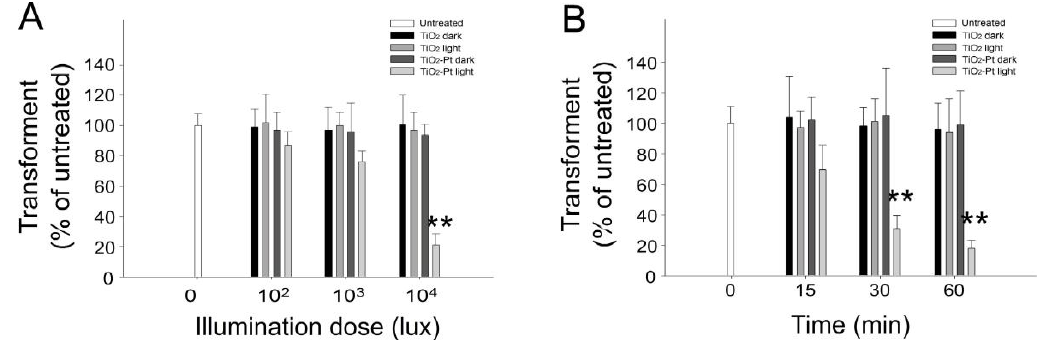
Figure 2. ( A ) Dose-dependent and ( B ) kinetic responses, with increasing illumination density and with increasing time, respectively. The visible light stimulated TiO 2 -Pt photocatalysis-mediated DNA damage was determined by the reduction of transformants. The DNA samples of those dark groups were covered with aluminum foil to prevent the photocatalysis. UV-responsive TiO 2 NPs were used as control materials. ** p < 0.01 vs. respective TiO 2 -Pt dark groups. n = 6, three experiments with two replicates.